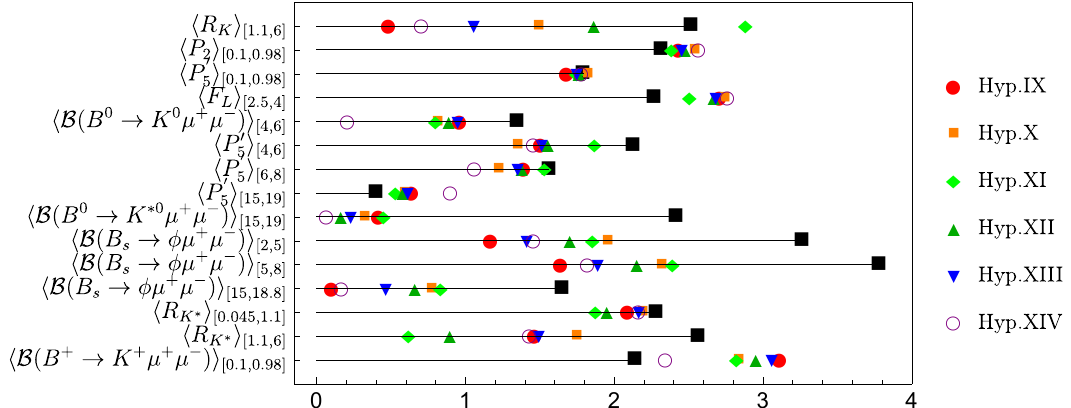
Figure 11. pull obs de(cid:12)ned in eq. (4.1) for each selected observable within di(cid:11)erent NP hypotheses (from IX to XIV) compared to the Standard Model (black